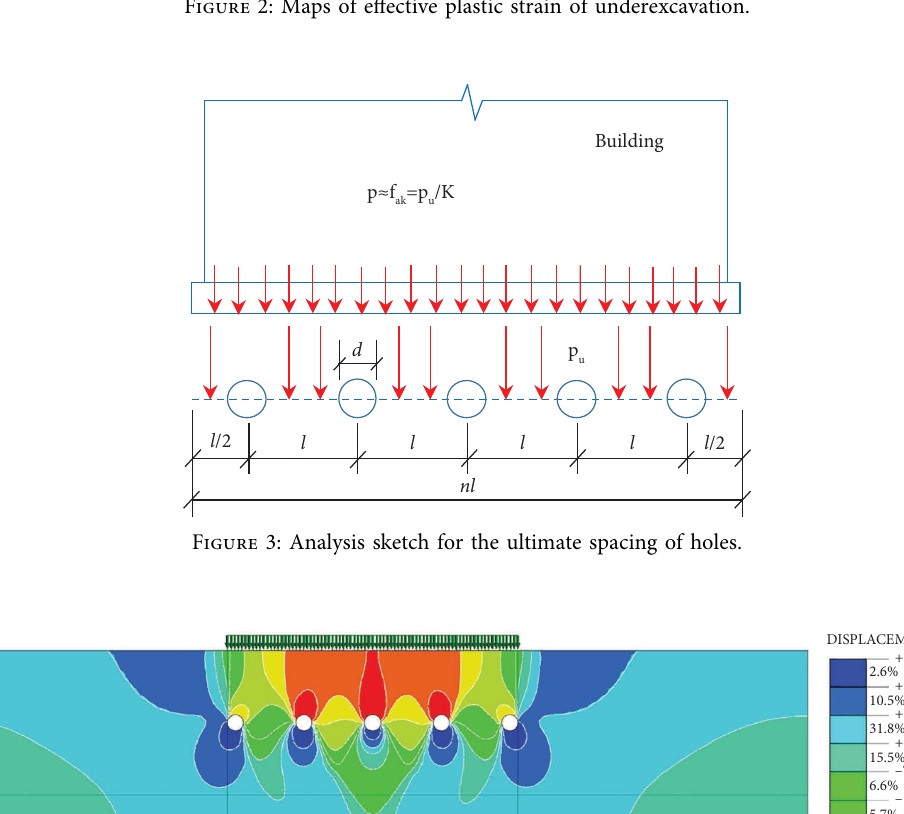
Figure 2: Maps of efective plastic strain of underexcavation.